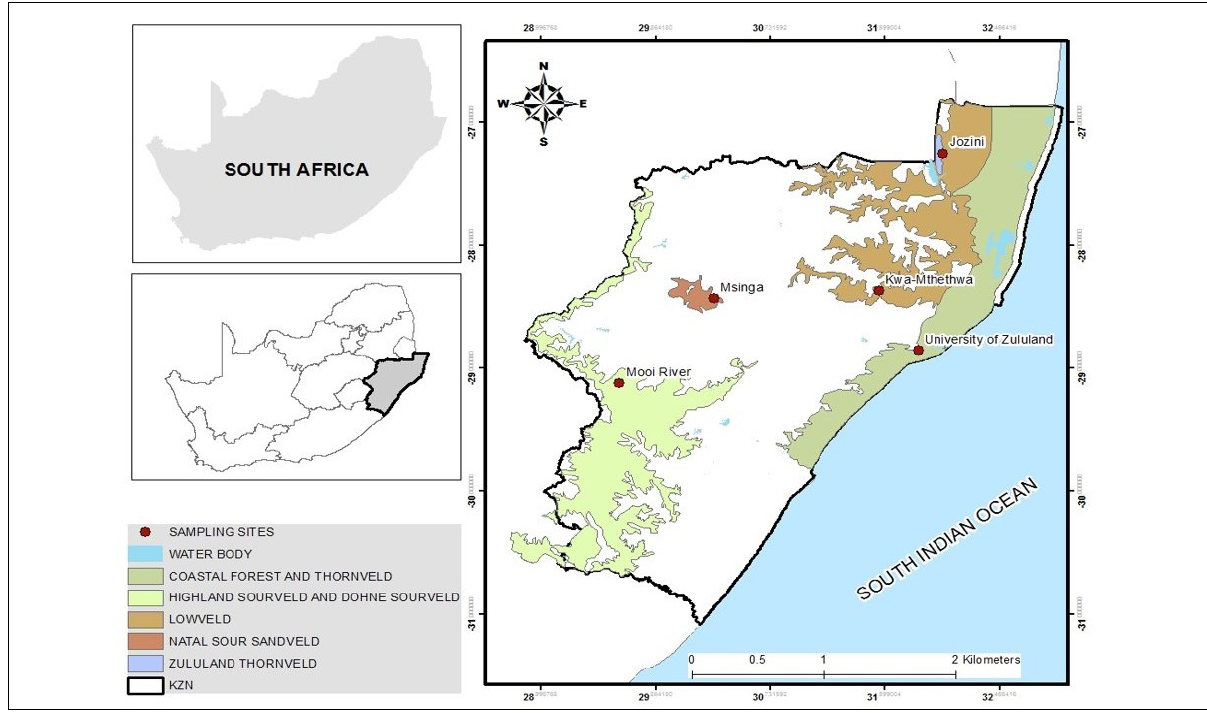
Figure 1: Map of South Africa showing the geographical location of study